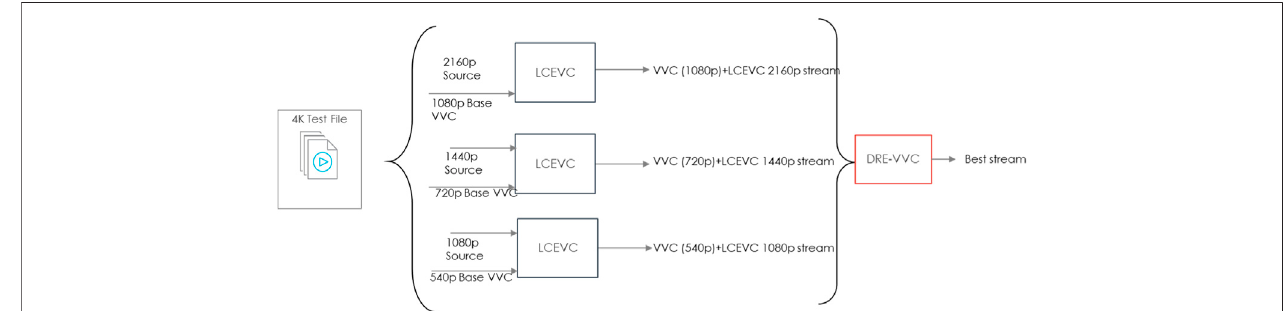
FIGURE 14 | Diagram for test